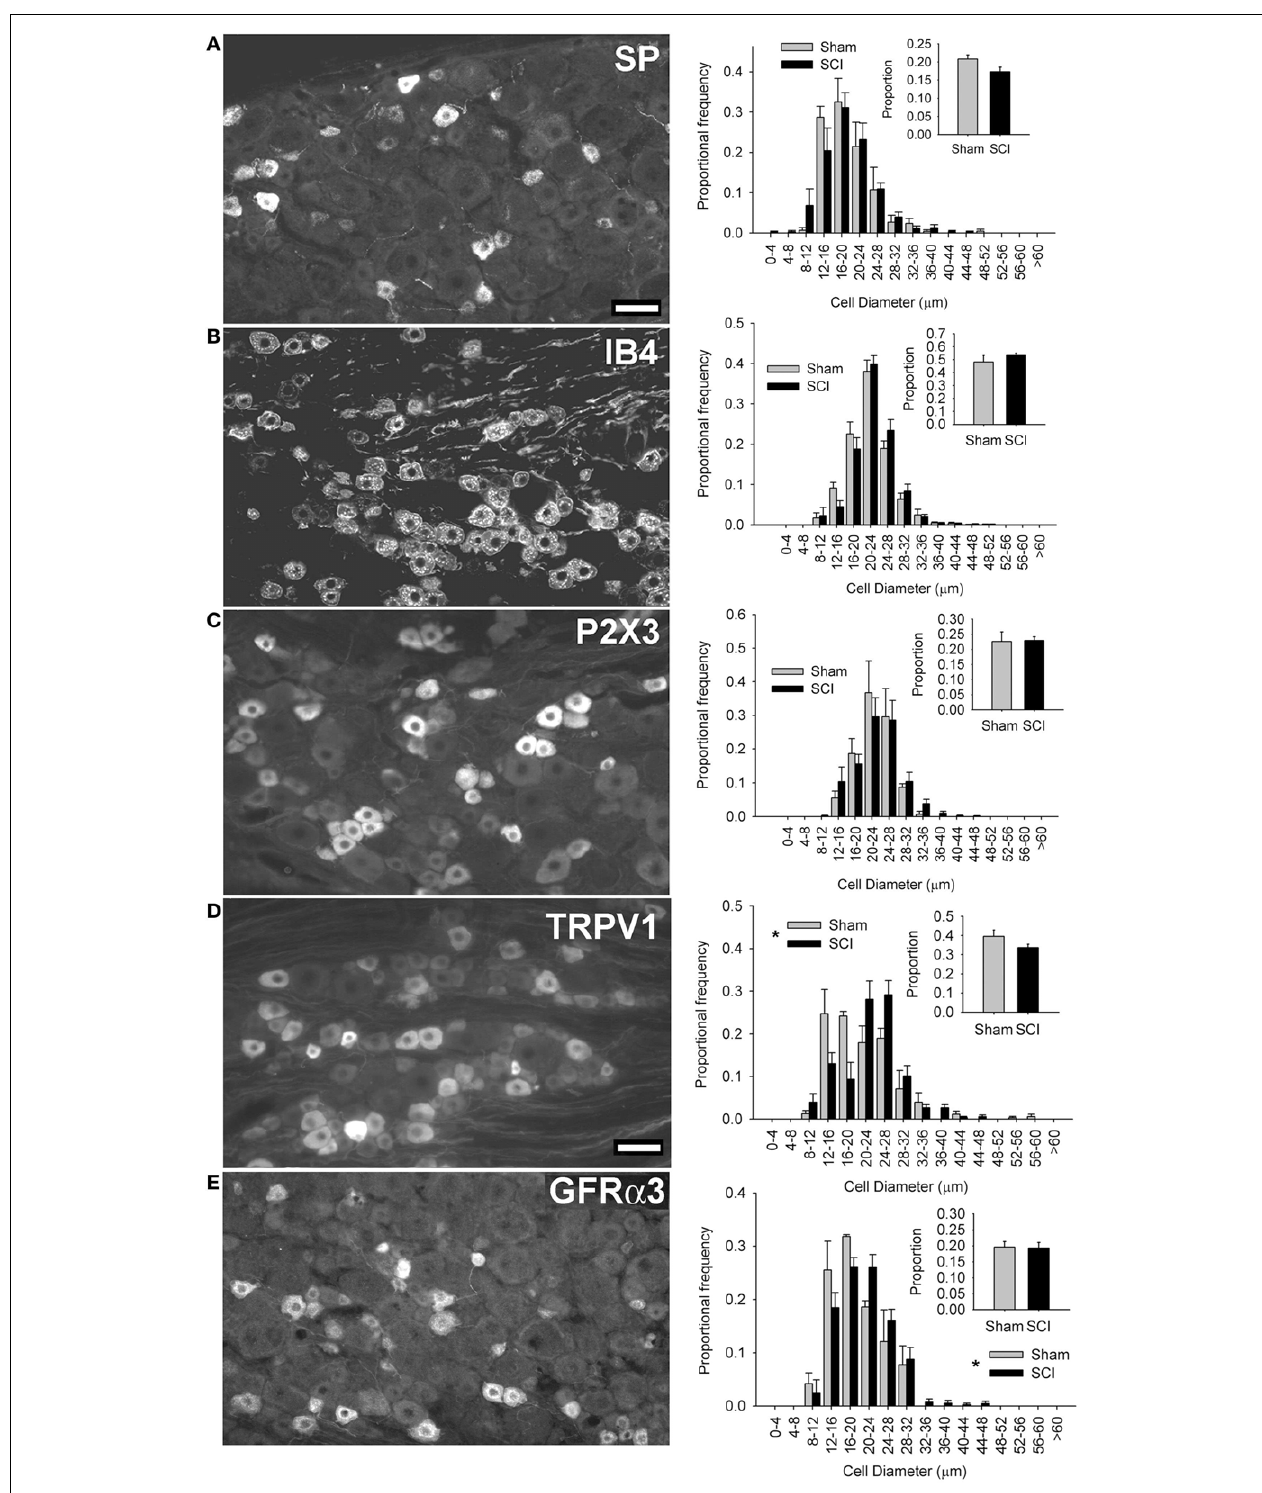
FIGURE 2 | High-thoracic (T3) spinal cord injury-induced selective hypertrophy of sensory neurons expressing the capsaicin receptor (TRPV1) and the artemin receptor (GFR α 3) in the L4/L5 DRG. (A) Substance P (SP) – positive DRG neurons and their size-frequency distributions. (B) IB4-binding DRG neurons. (C) P2X3-positive DRG neurons.